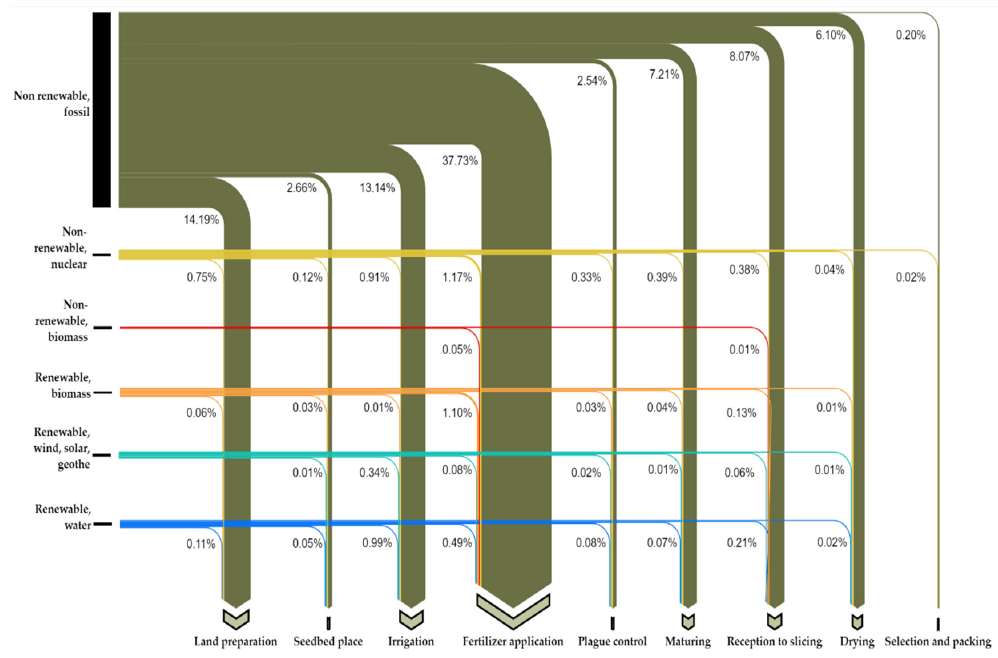
Figure 13. The energy footprint of dehydrated pineapple by the main processes.